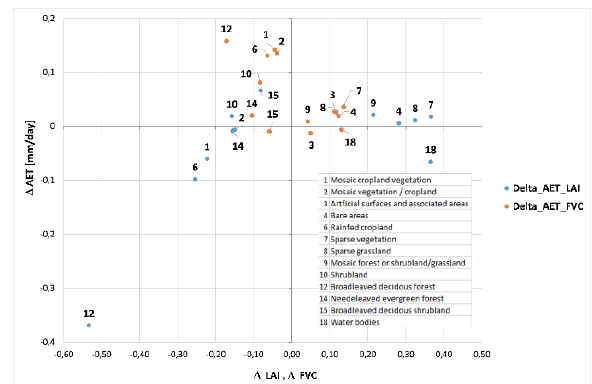
Figure 10. Scatter plot of AET change against LAI and FVC maps change aggregated by land cover types for May 6, 2010 in Medjerda